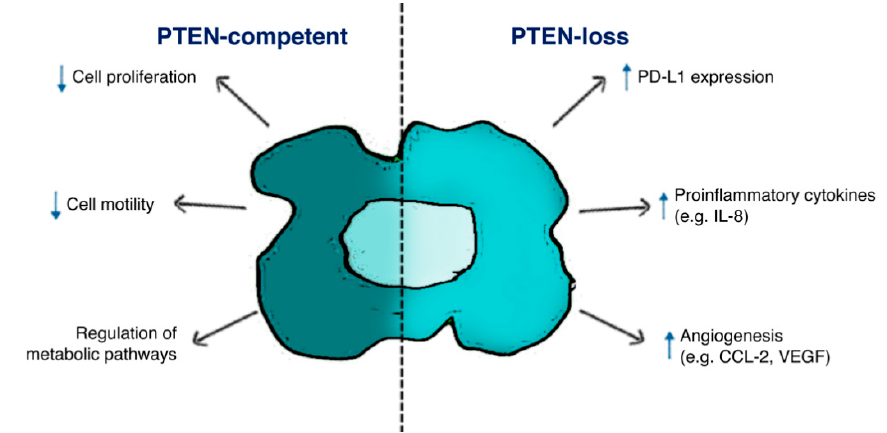
Figure 2. Schematic illustration of PTEN function in tumor cells. PTEN-status in cancer cells affects both biological features in cancer cells survival and tumor microenvironment (TME) composition, according to the expression of specific ligands (i.e., PD-L1) and soluble factors (i.e., IL-8, CCL-2, VEGF).